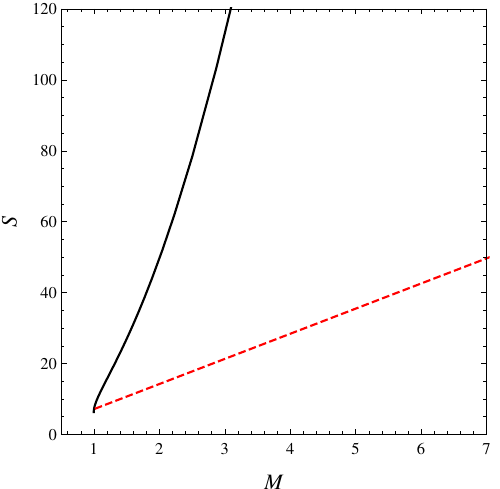
Figure 2. Plots of entropy S as a function of the mass–energy parameter M at fixed J , standard (black solid) and formal logarithm (red dashed) approaches. The standard entropy is asymptotically convex (being proportional to M 2 in the large M limit). The new entropy is a straight line because the entropy is proportional to the mass–energy.